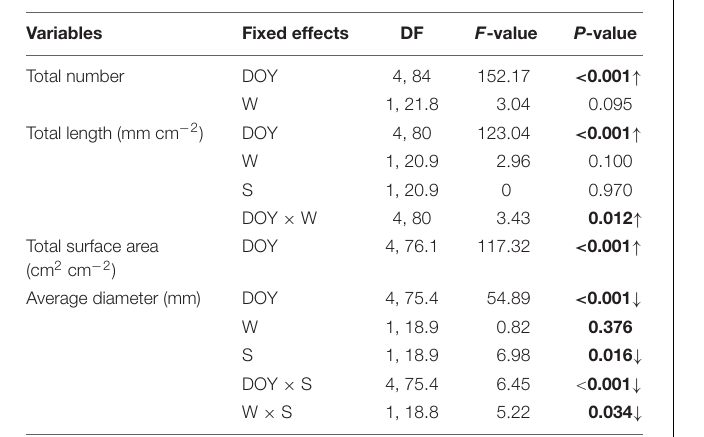
FIGURE 5 | Increment of cumulative root length growth between consecutive measurement campaigns (mean ± SE) estimated at each treatment plot: control (C), warming by OTCs (W), snow accumulation (S), and snow + warming by OTCs (SW). The significant effect of day of year (DOY) is indicated by ∗∗∗ P ≤ TABLE 4 | P -values of main treatment effects and interactions on root parameters during each measurement campaign (ANOVA mixed model). Parameters